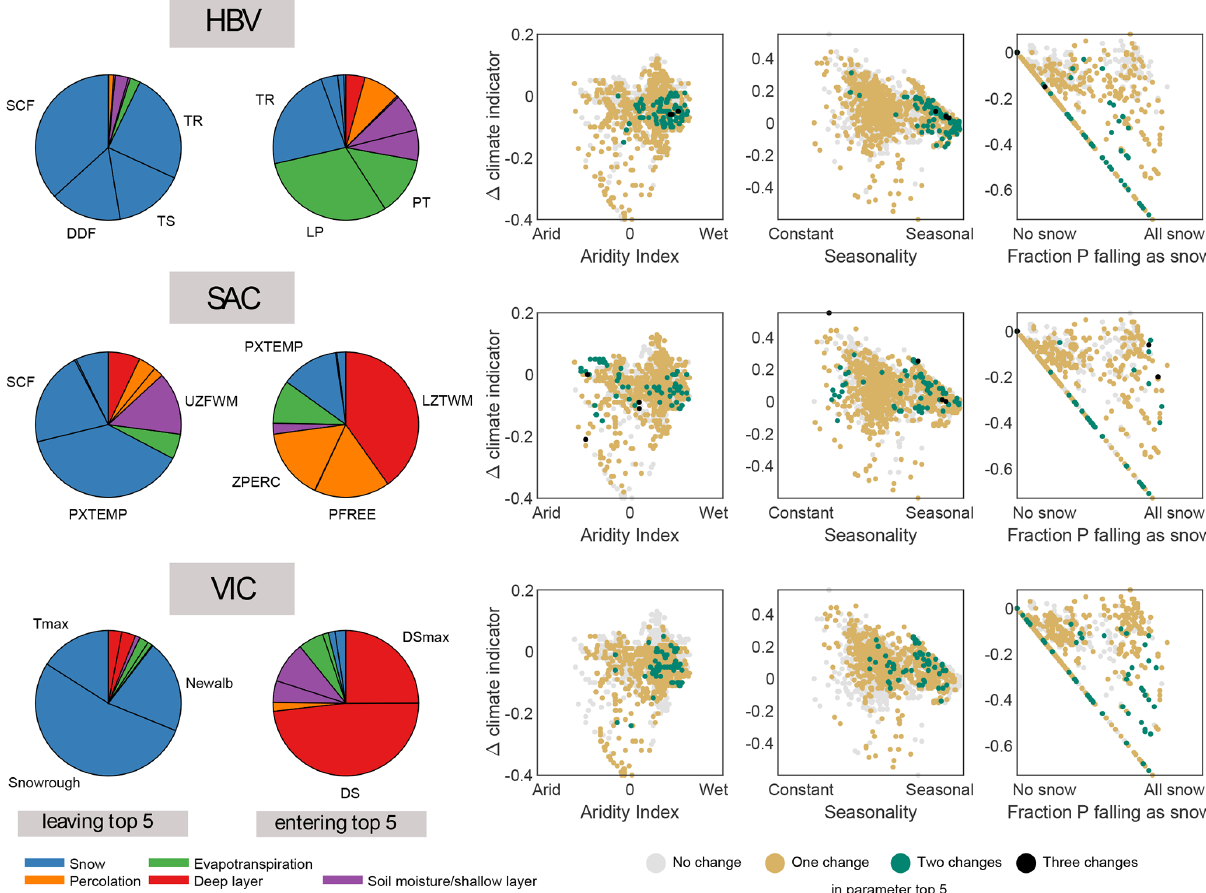
Figure 6. Impact of change in parameter sensitivity on top-5 position for the mean discharge, where top-5 refers to the five most sensitive parameters per basin – generally the parameters that are calibrated. The pie charts show which parameters leave the top-5 (left) and which parameters enter the top-5 (right). The right panels relate the number of changes in the parameter top-5 to climate and climate change